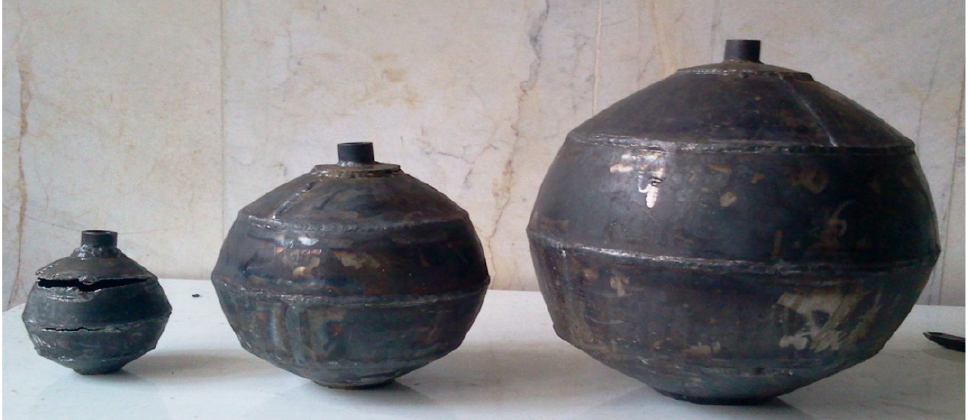
Figure 10. Test samples subsequent to explosion in three different diameters: D = 100, 200 and 300 mm , t = 4 mm.